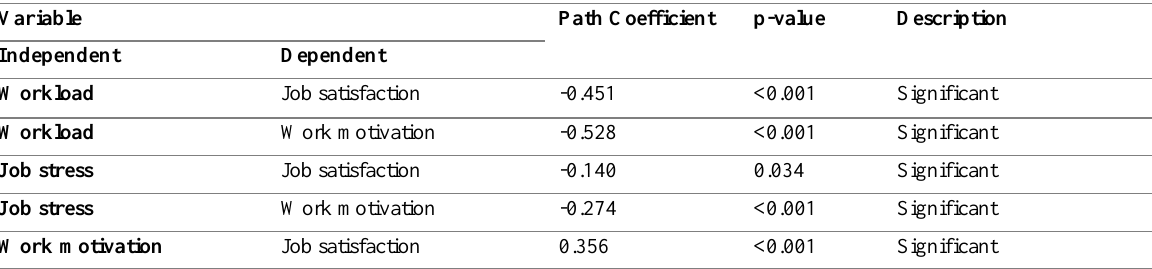
Table 5: Direct Hypothesis